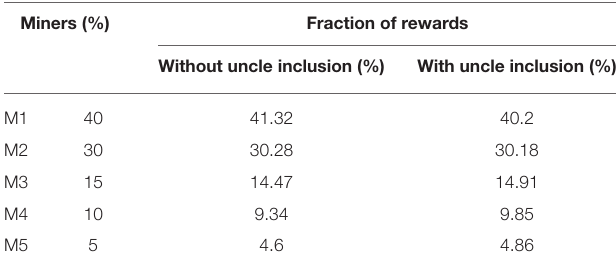
TABLE 6 | The fraction of rewards gained by each miner (M1,M2,…,M5), with and without uncle inclusion mechanism. Miners (%) Fraction of rewards Without uncle inclusion (%) With uncle inclusion